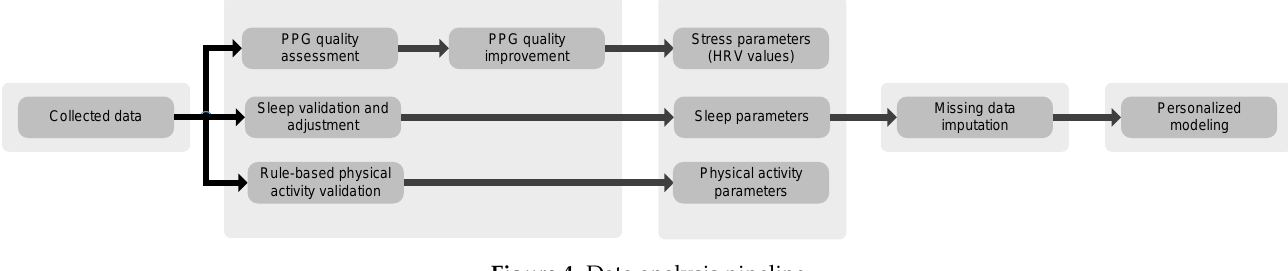
Figure 4. Data analysis